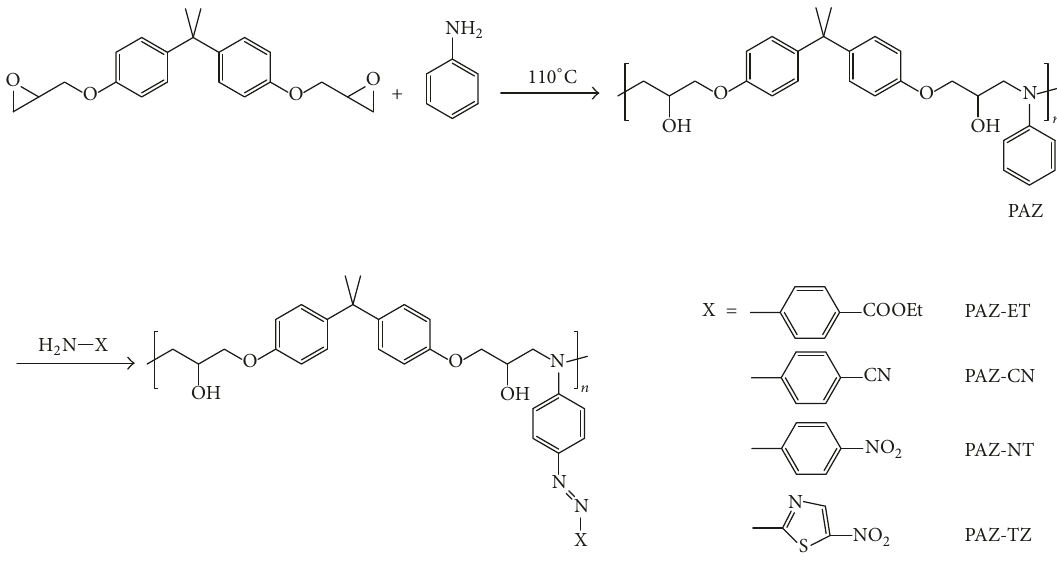
Figure 1: Synthetic route for the azo